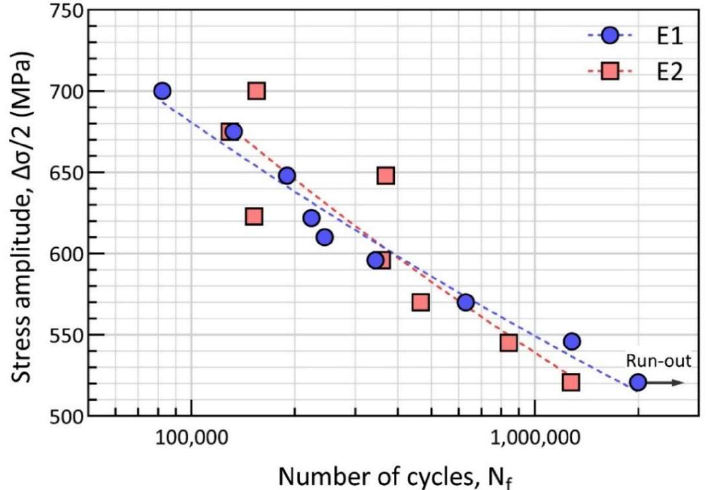
Figure 9. Fatigue stress/life (S-N) curve for E1 and E2 specimens.